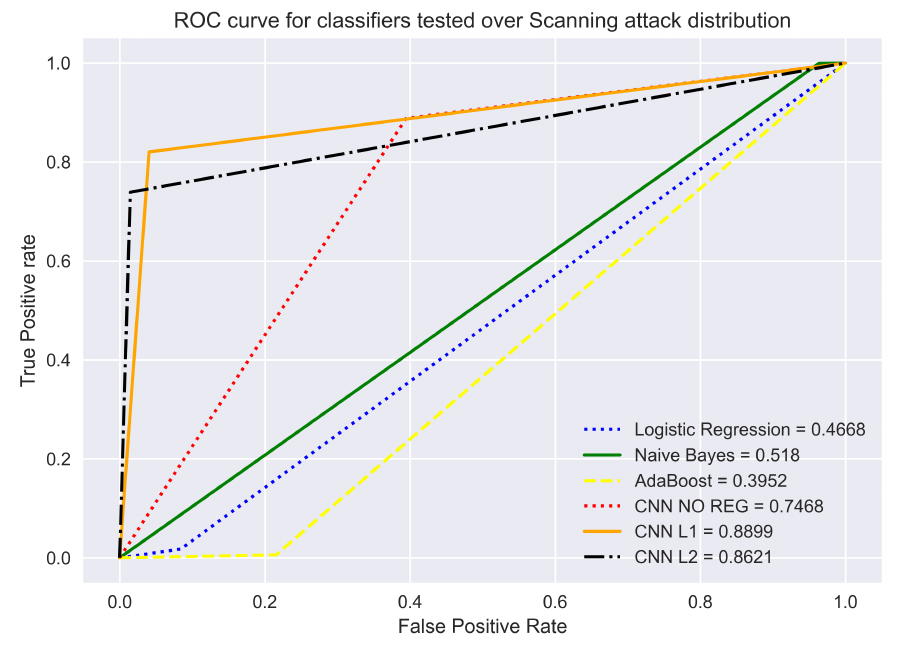
Figure 5. Plot of all classifiers’ ROC In Scenario B.